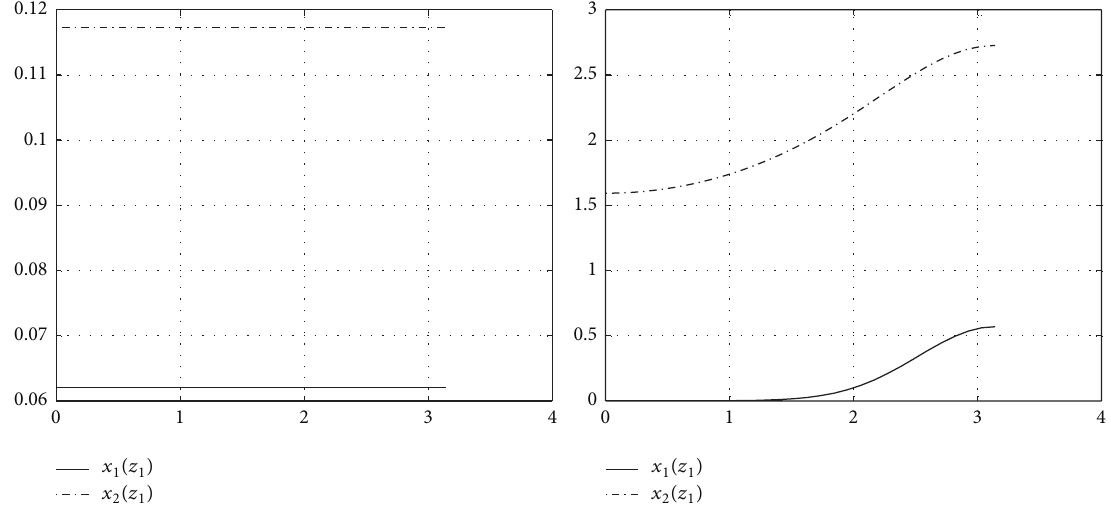
Figure 4: Numerical results on spatial convergence of 𝑥 1 ,𝑥 2